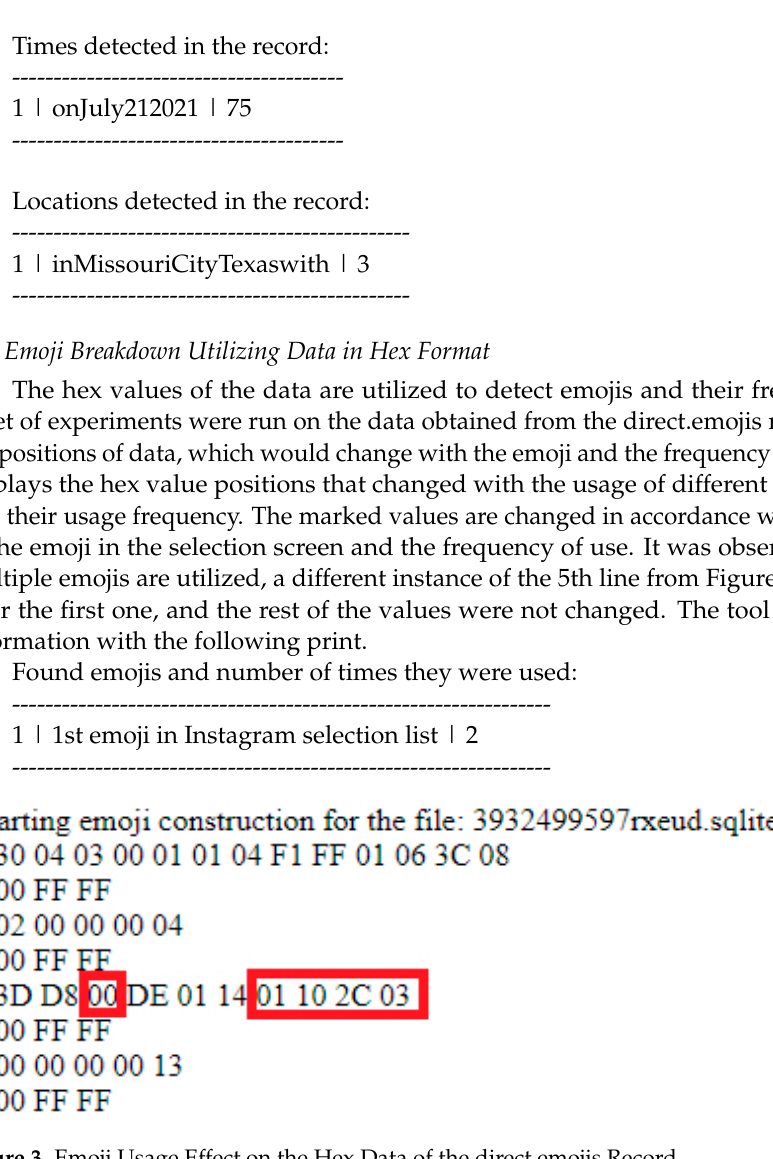
Figure 3. Emoji Usage Effect on the Hex Data of the direct.emojis Record.